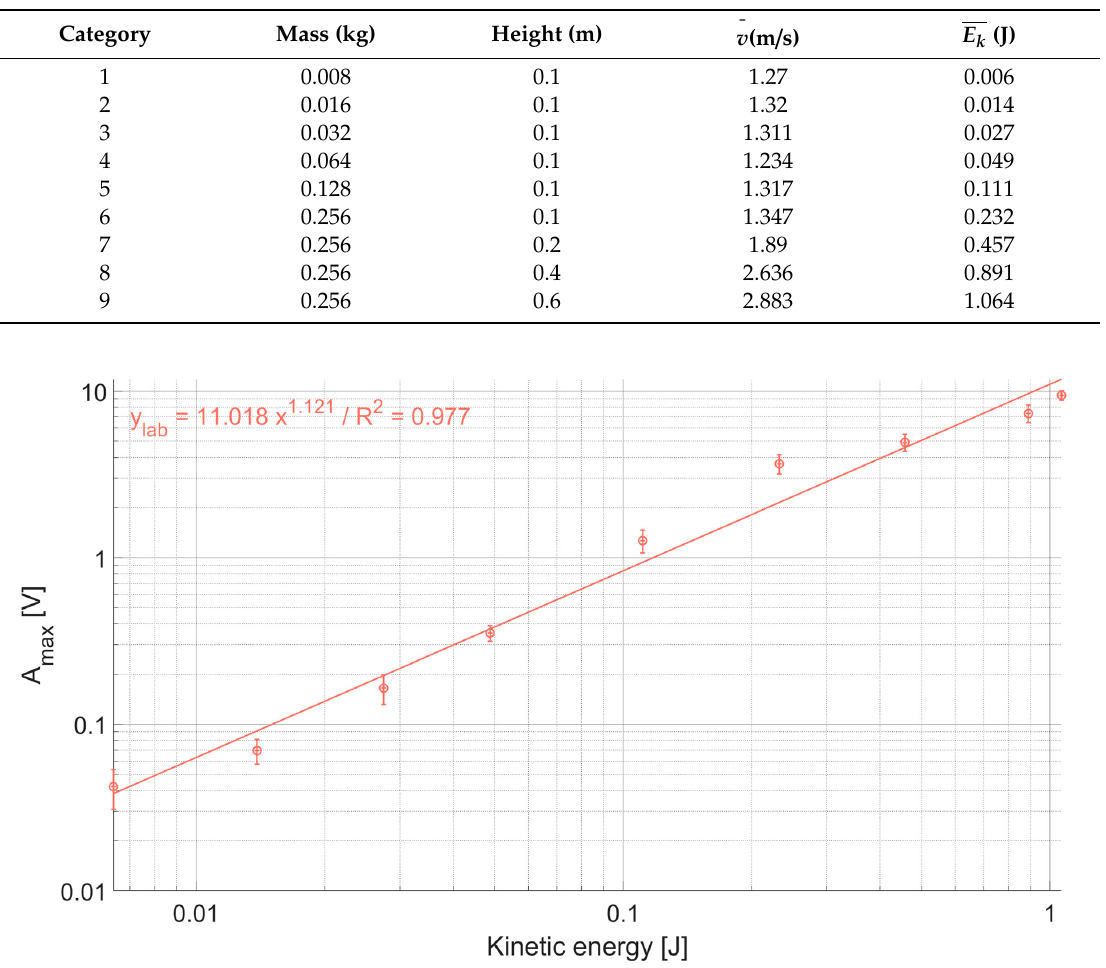
Figure 3. The maximum amplitude A max recorded by the laboratory plate is best expressed by a power law function of the kinetic energy released by the impact, with an exponent slightly above 1.